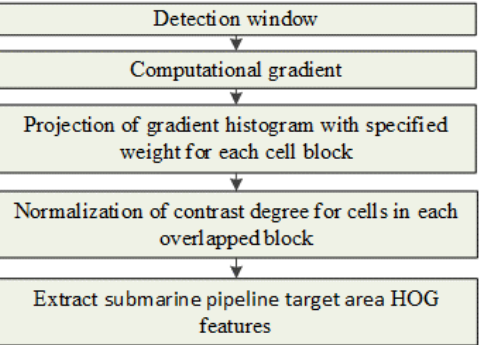
Figure 5. Histogram of oriented gradient (HOG) feature extraction algorithm flow.